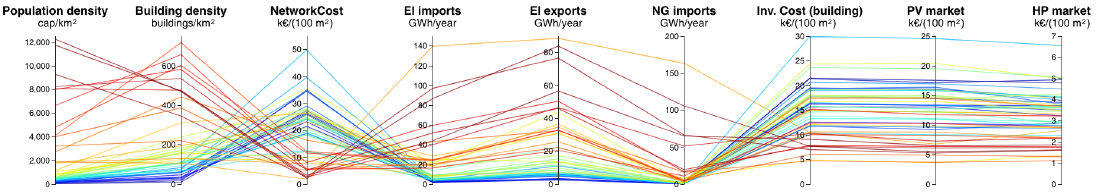
Figure 17. Parallel coordinate representation of the communes for the lowest operating cost solution. Figure 18 is used to detail the energy flows in the communes, by displaying the detailed contributors of electricity and natural gas import/export at the building level for each commune and at the canton level. The results show that: